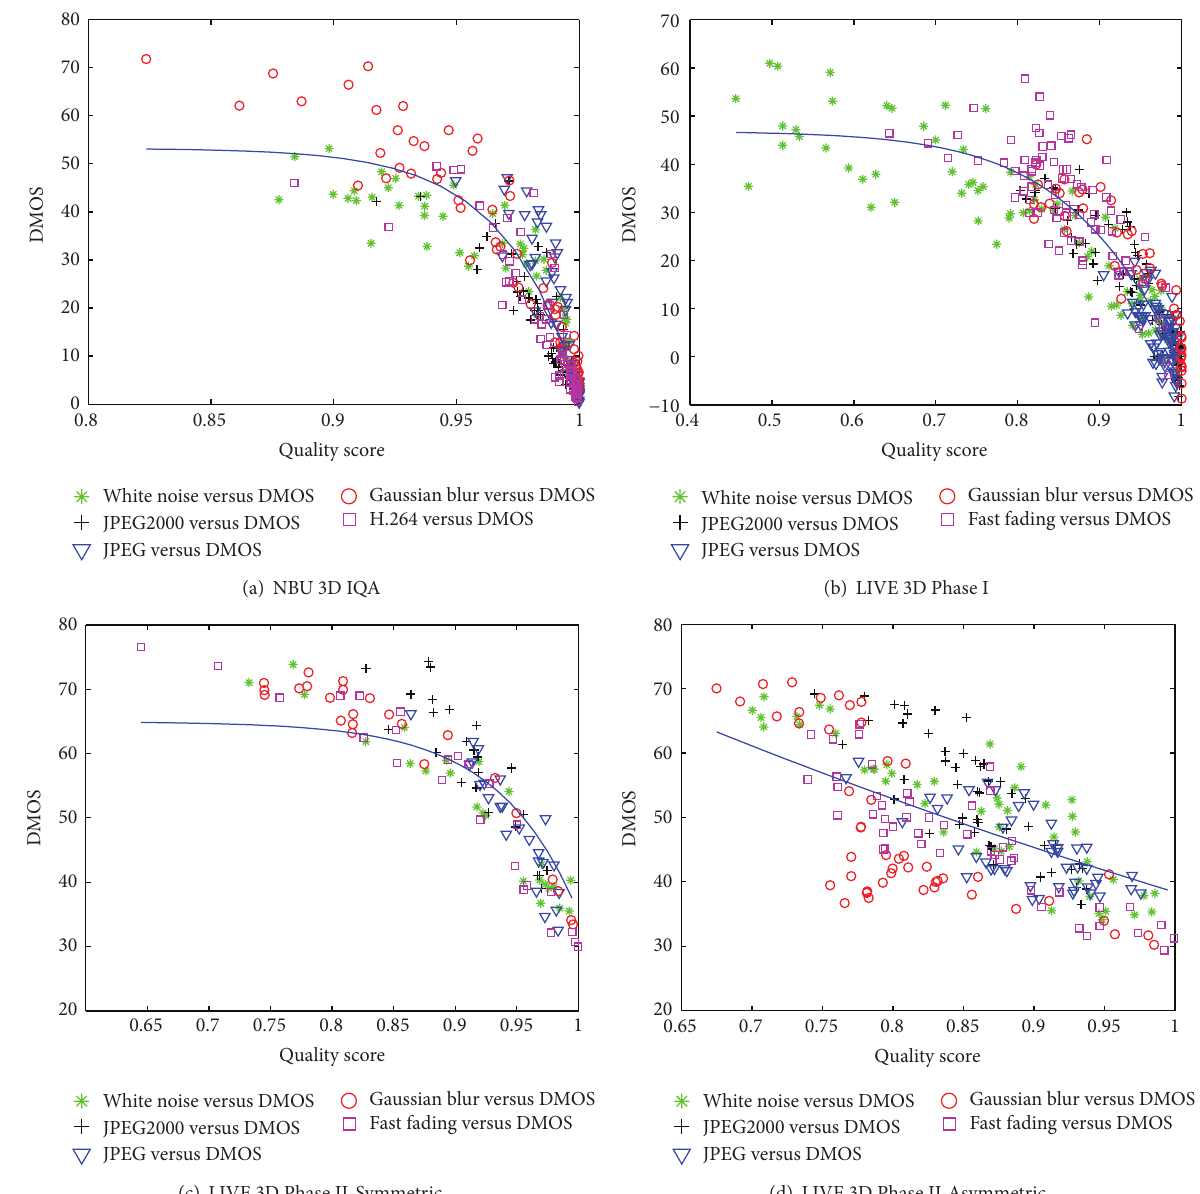
Figure 4: Scatter plots of predicted quality scores against the subjective scores (DMOS) of the proposed method on four